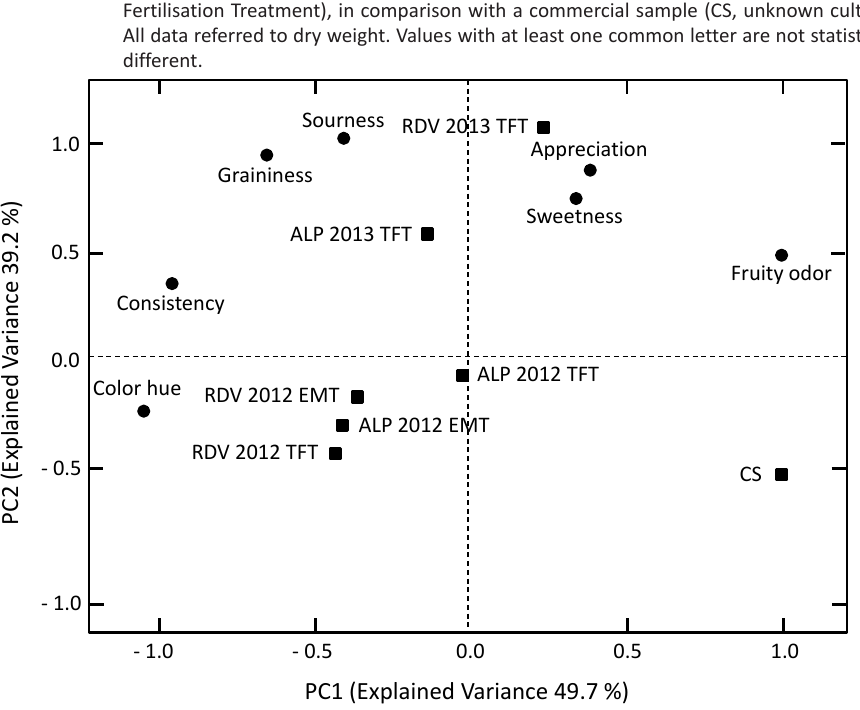
Fig. 2. Score and loading bi-plot in the Cartesian plane of the first two principal components obtained from the factor analysis of the seven F. vesca samples and the seven sensorial variables investigated within the panel test analysis